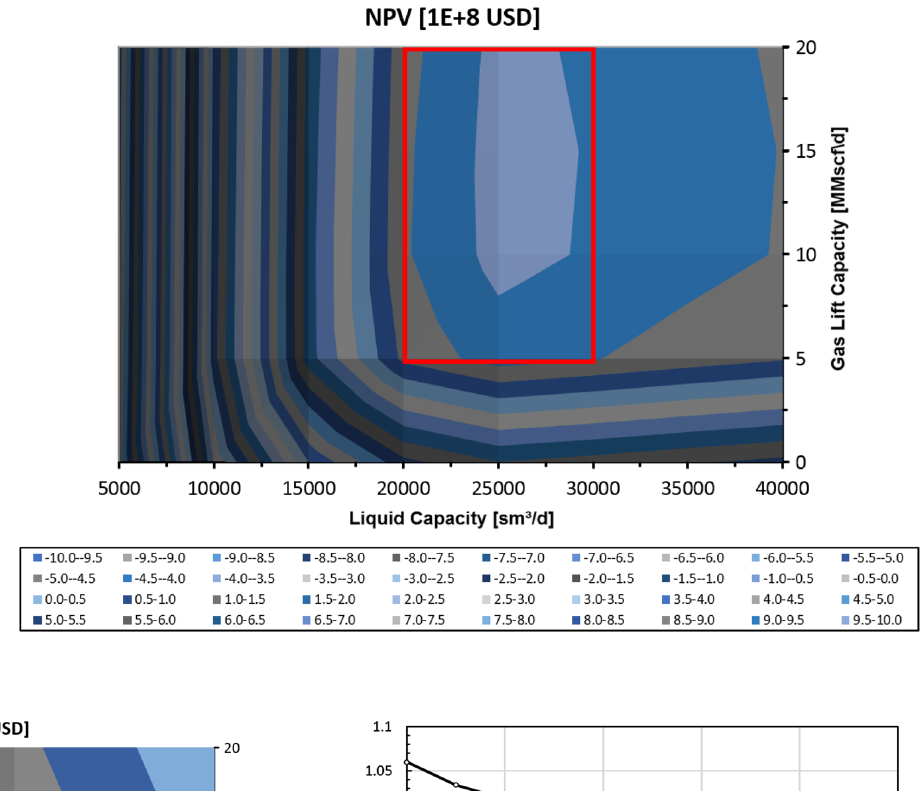
Fig. 18 NPV as a function of liquid and gas lift capacities. The red square indicates the sweet zone to be further investi- gated for optimization